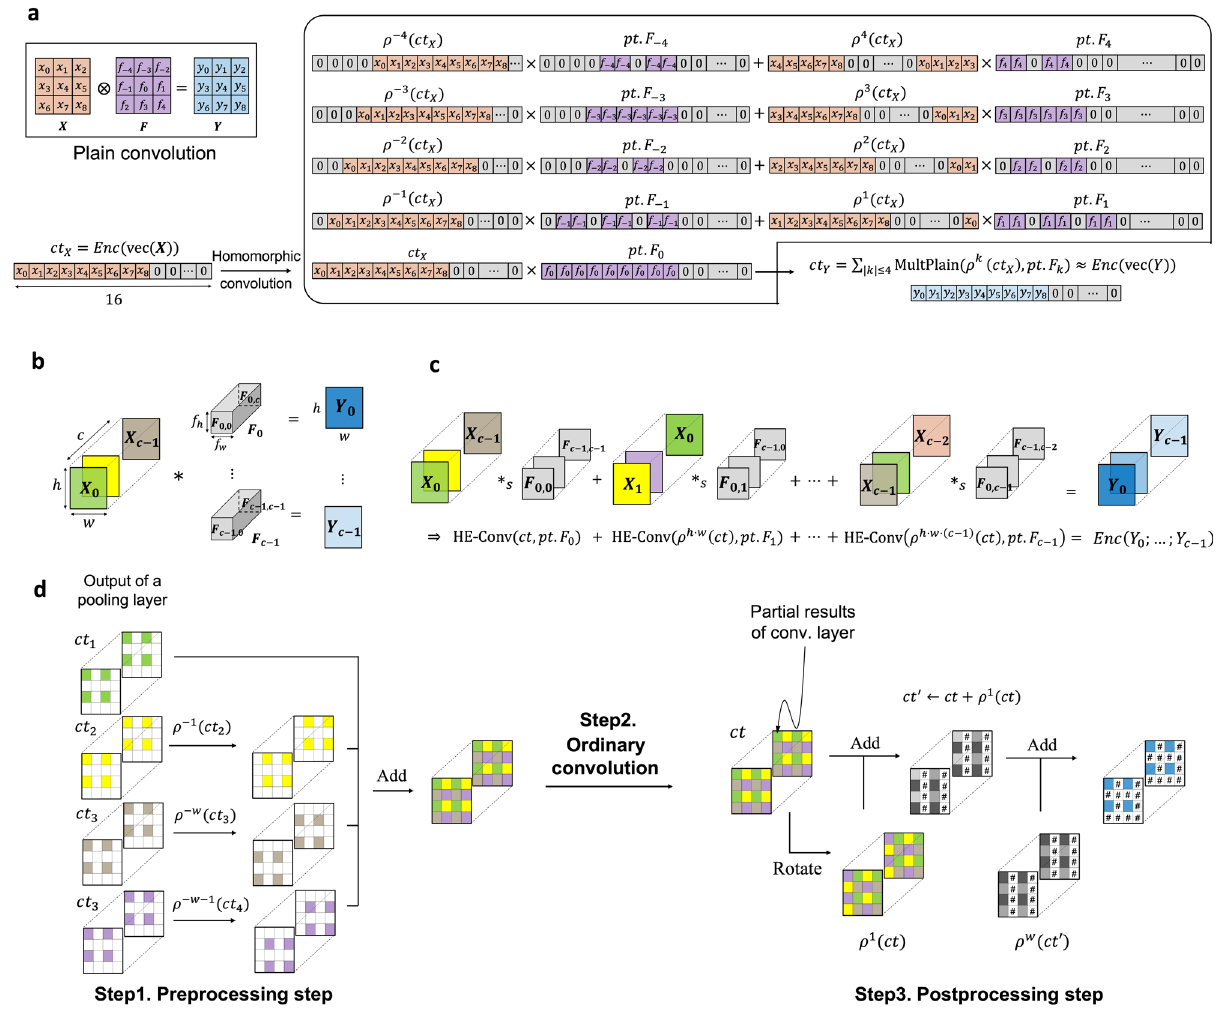
Fig. 6 | Illustration of homomorphic 2D convolution operations. a Homomorphicevaluationofordinary2Dconvolutionwithakernelsizeof3anda stride of 1. We denote by vec ( ⋅ ) a row-major vectorization, Enc ( ⋅ ) an encryption function, ρ ℓ ( ⋅ ) a ciphertext rotation to the left by ℓ positions, and MultPlain a plaintext-ciphertext multiplication. b Plain convolution algorithm of the feature 2 R c × f h × f w g 0 (cid:5) j < c on an input X = f X i 2 R h × w g 0 (cid:5) i < c and an out- maps f F j = ð F jl Þ c (cid:4) 1 l =0 put Y = f Y i 2 R h × w g 0 (cid:5) i < c . Operation * indicates the multi-channel convolution. c Homomorphic convolution algorithm. The input X is given as a fully